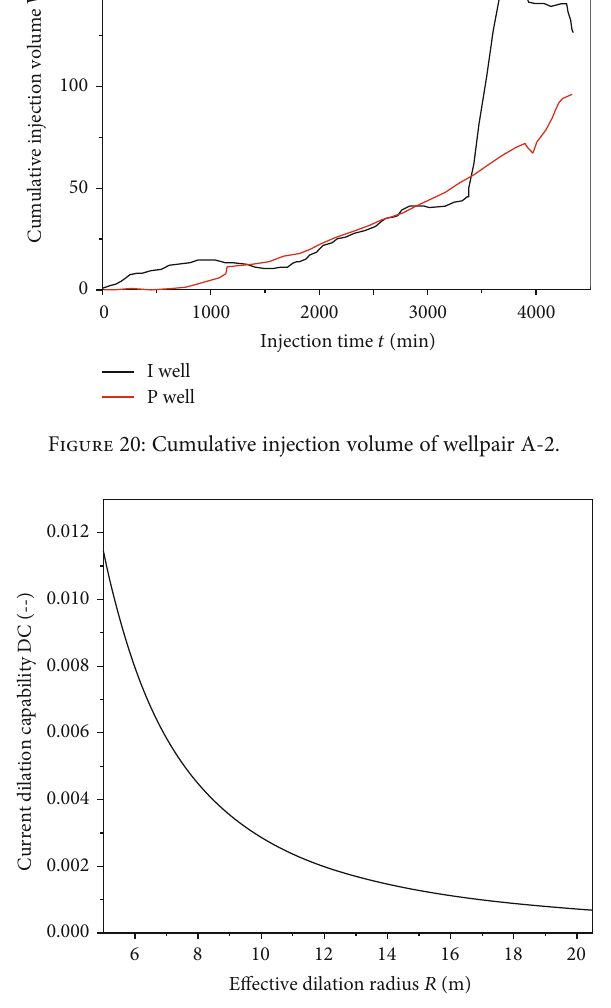
Figure 21: Current dilation capability evaluated by injection